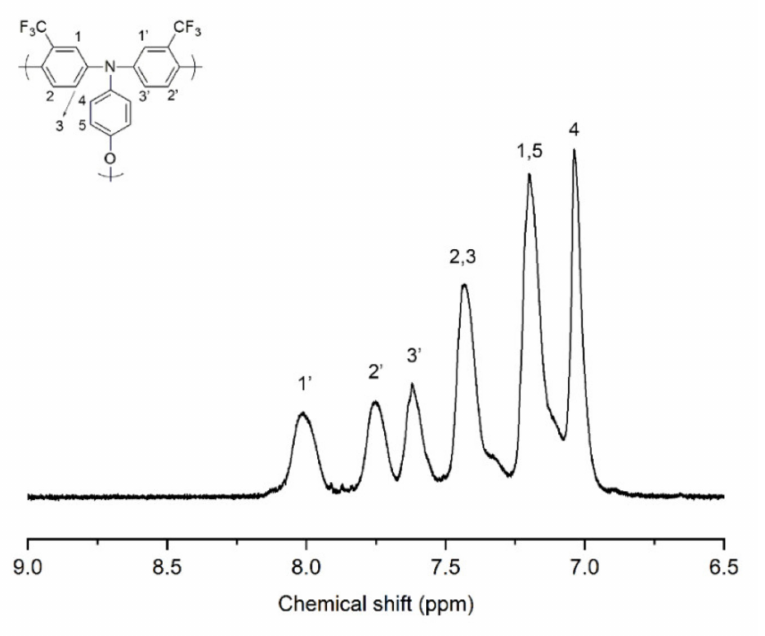
Figure 3. 1 H NMR spectra of PTPA (DMSO- d 6, 600 MHz).